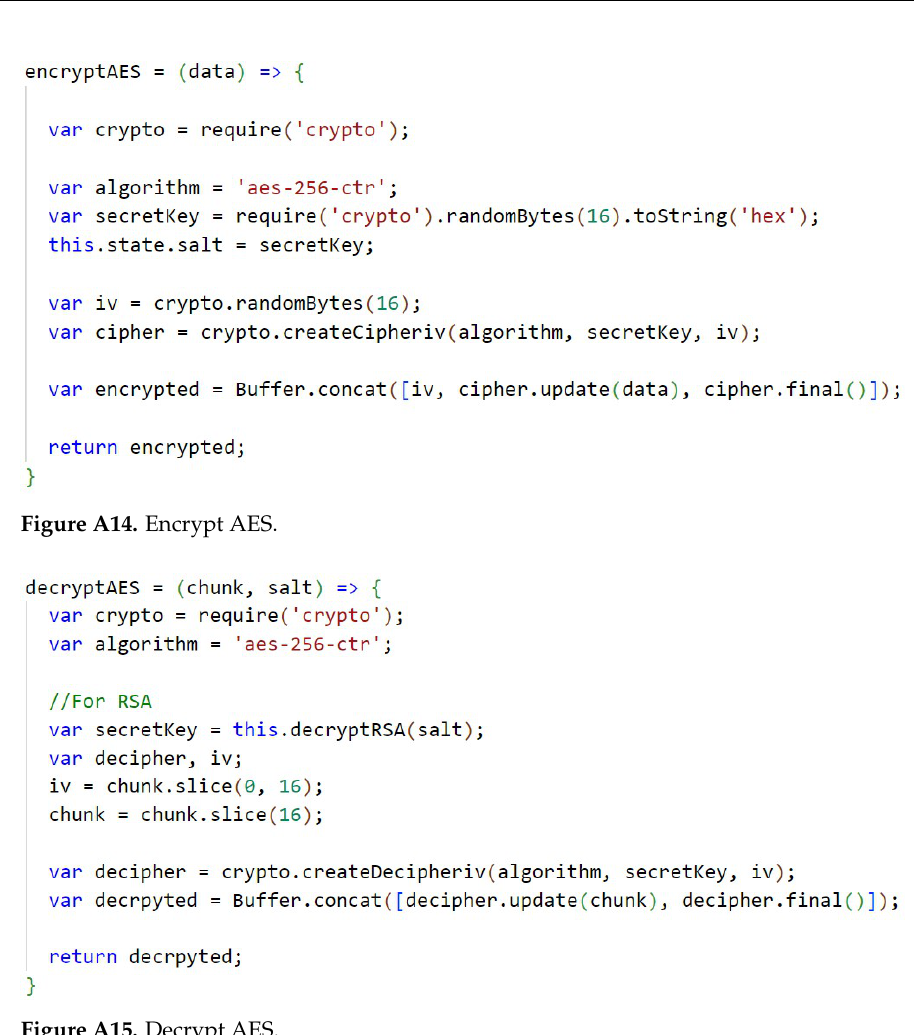
Figure A15. Decrypt